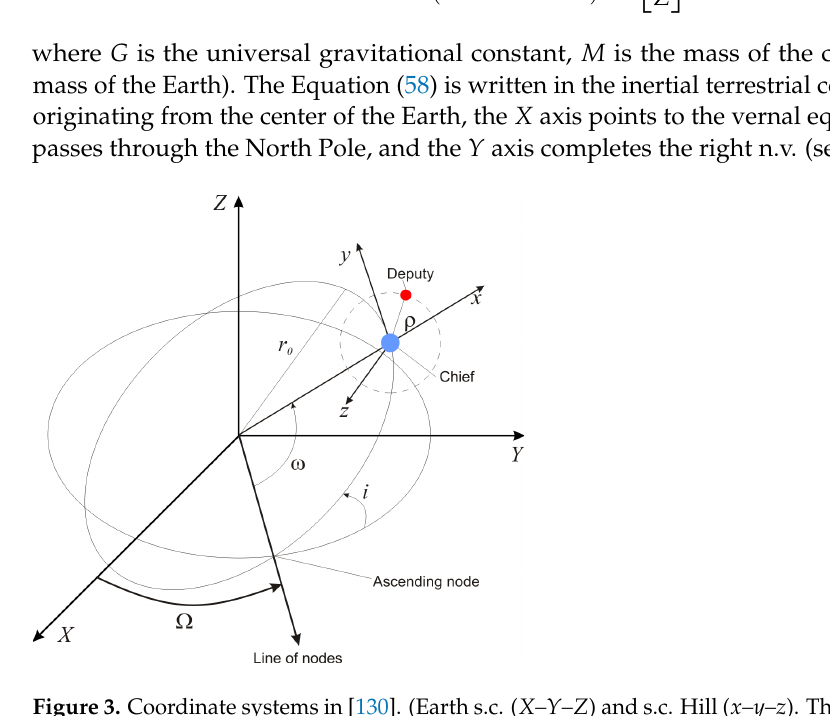
Figure 3. Coordinate systems in [130]. (Earth s.c. ( X–Y–Z ) and s.c. Hill ( x–y–z ). The distance between the leading and trailing satellites on the yz -plane of the local rotating coordinate system x–y–z must be equal to the specified ρ